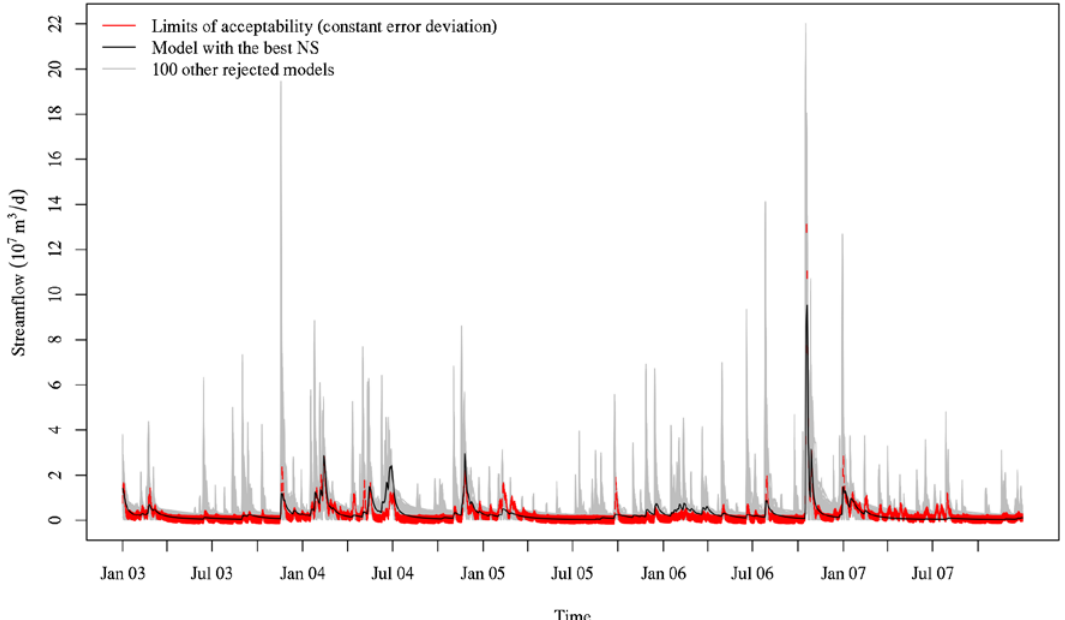
Figure 2. Constant error limits of acceptability, simulated flows with the best Nash–Sutcliffe (NS), and 100 other rejected models. Rejected models are plotted first to clearly show the limits of acceptability. The limits of acceptability using the non-parametric error deviation are not shown because the width of the limits is very narrow.